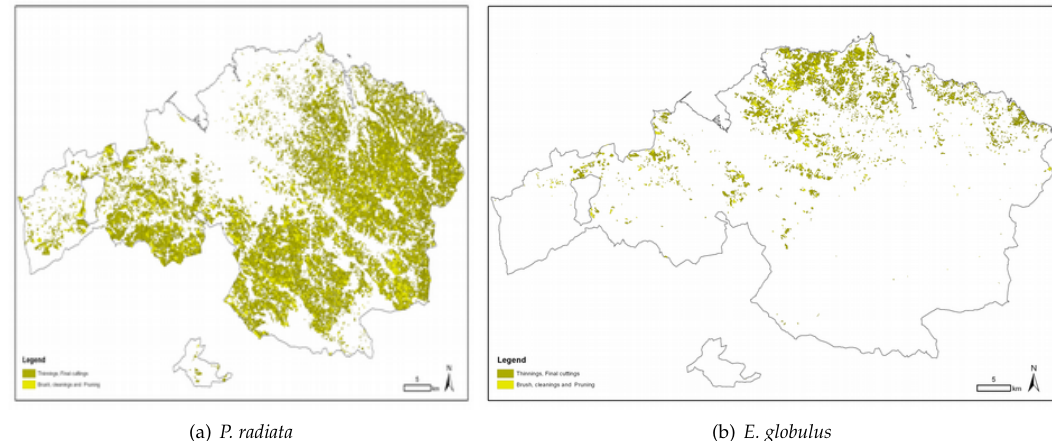
Figure 1. Plot map in Biscay in its different states